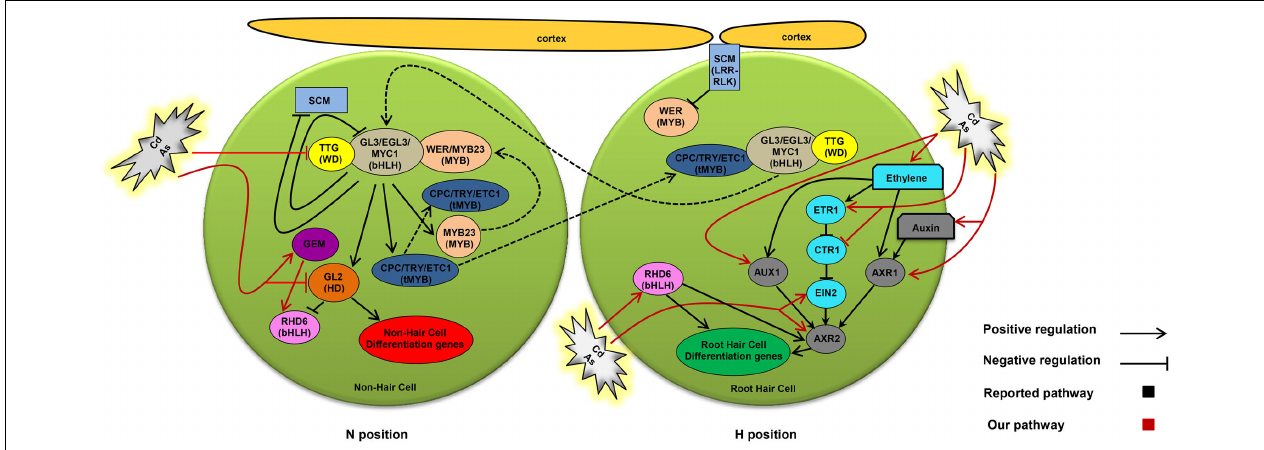
FIGURE 9 | Proposed model showing how cadmium and arsenic (As III) promote root hair differentiation and elongation through modulating intrinsic developmental and hormonal pathways in Arabidopsis . Arrows show positive regulation, blunted lines show negative regulation, and broken lines illustrate intercellular or intracellular protein translocation. This model is adapted from Bruex et al.